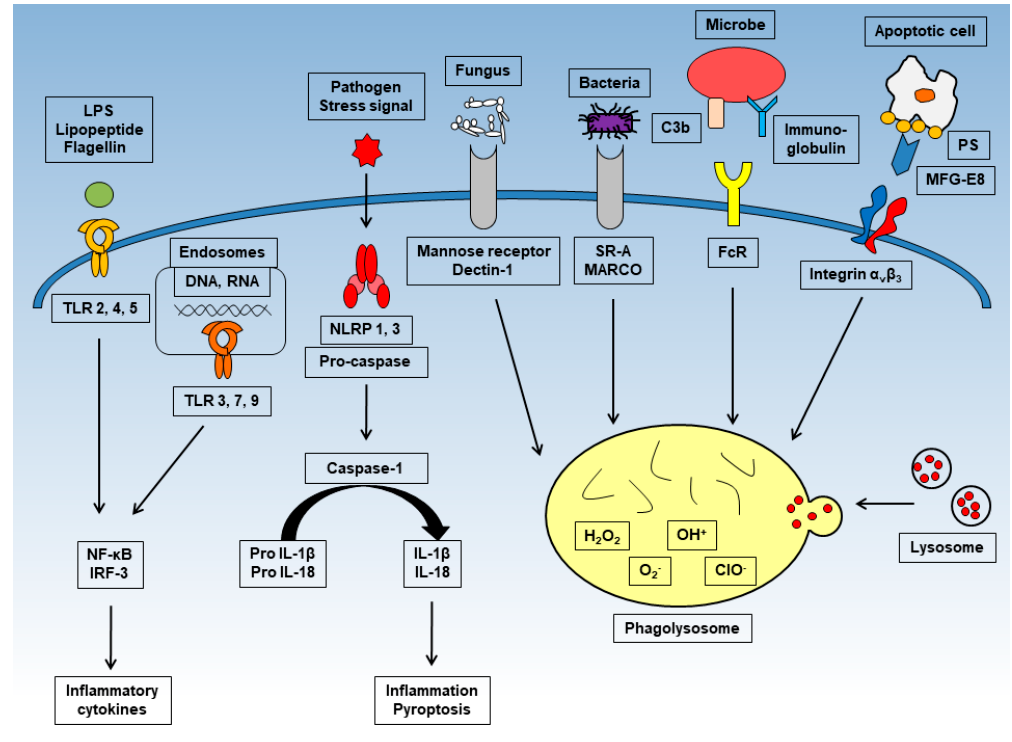
Figure 1. The inflammatory and phagocytic mechanisms of macrophages.